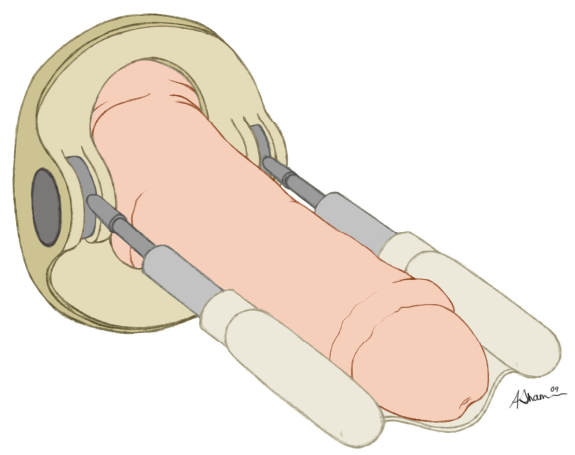
FIGURE 4. Penile traction